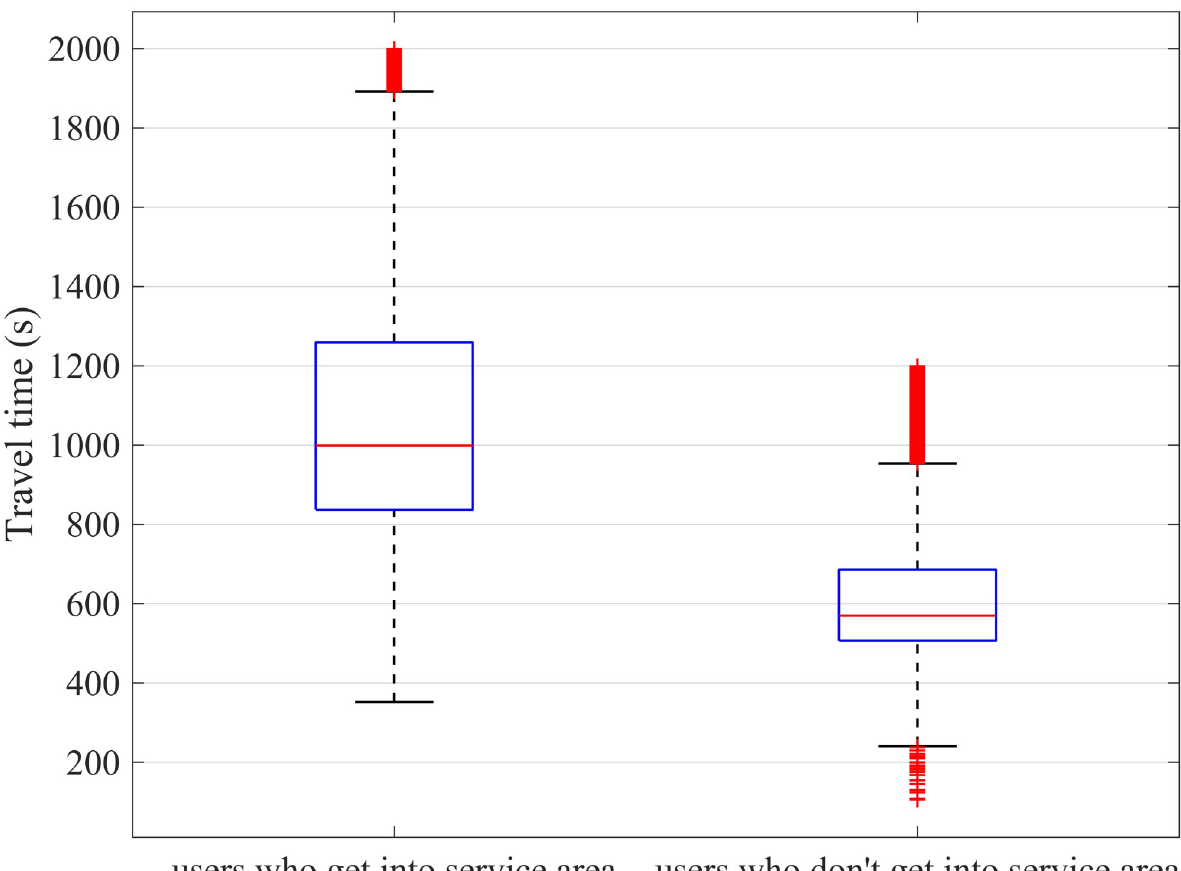
Fig 7. Boxplot of travel